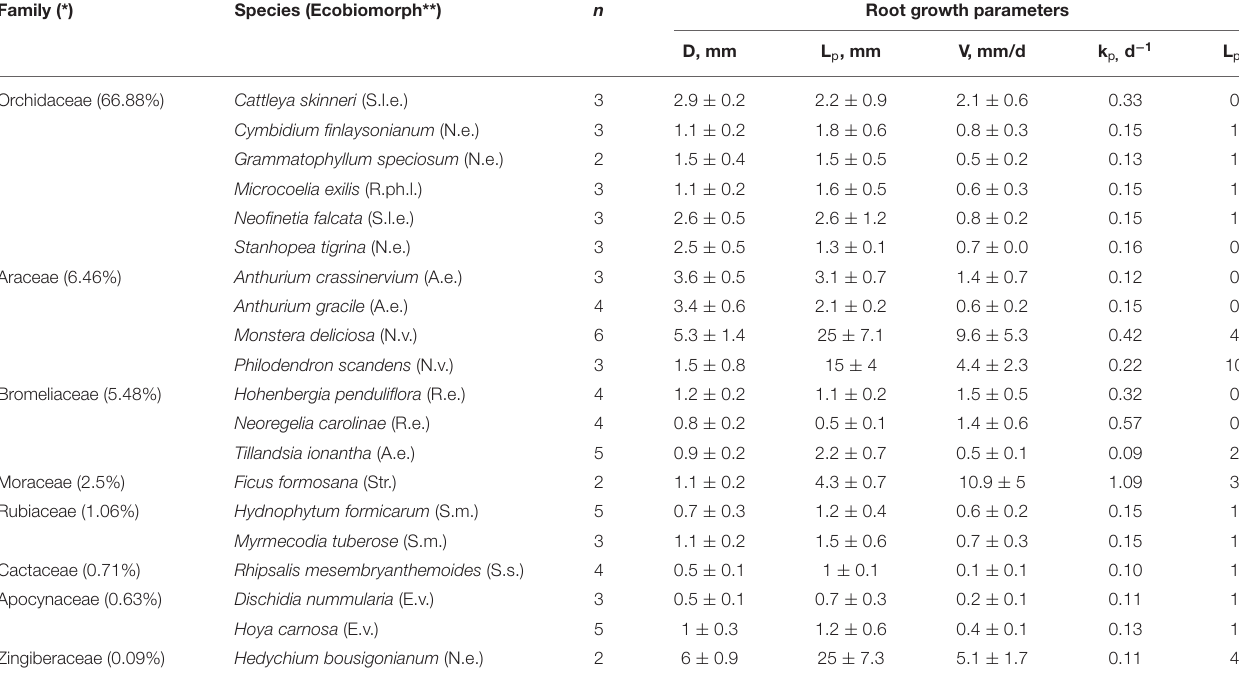
TABLE 2 | A summary table of the parameters characterizing the root growth of the studied flower epiphytes species ex-situ (mean ±